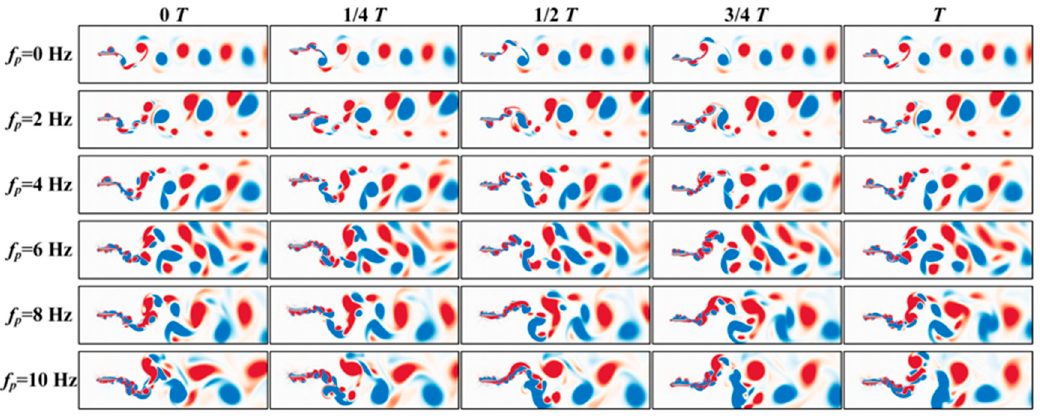
Figure 10. Instantaneous wake structure for foil at k = 5.